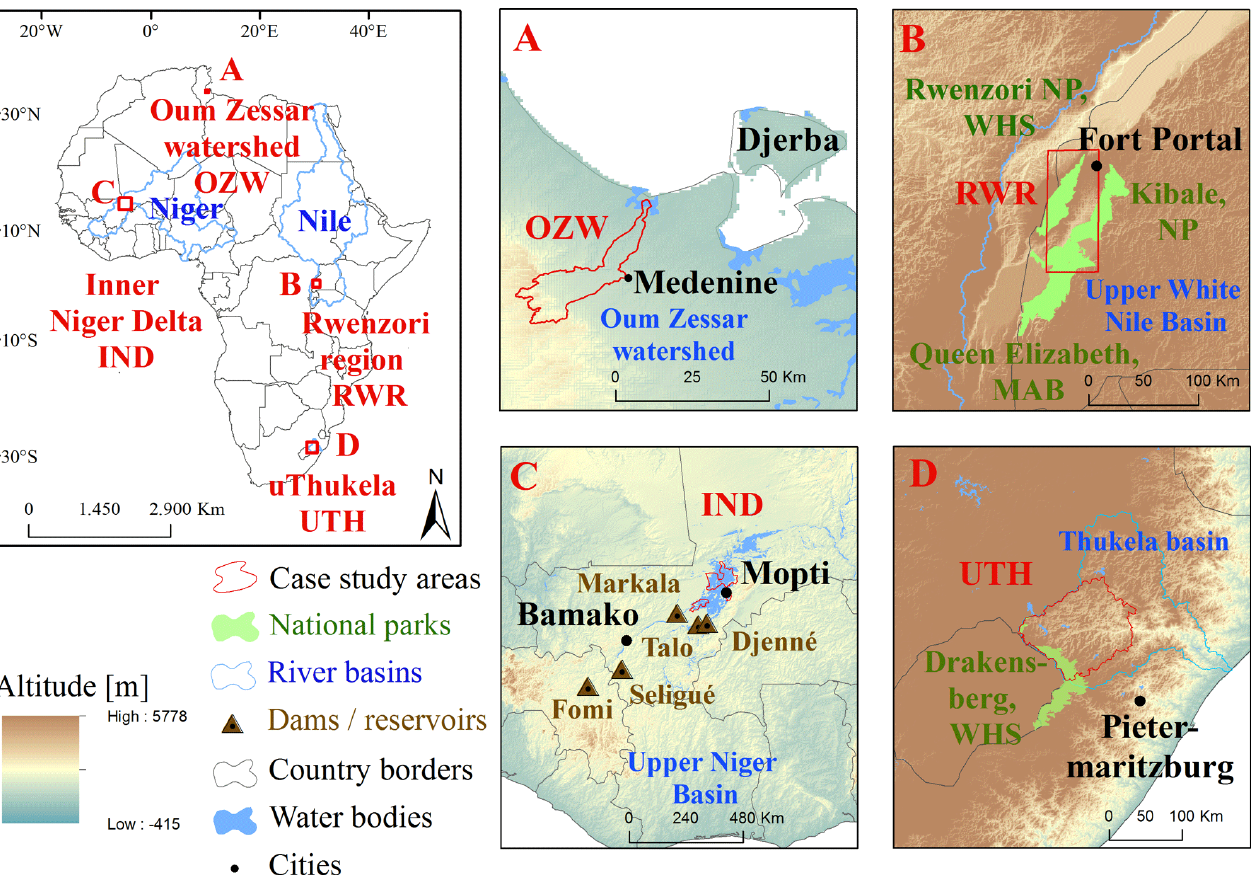
Fig. 1 . The four case study localities in Africa, (A) Oum Zessar watershed (Tunisia), (B) Rwenzori region (Uganda), (C) Inner Niger Delta (Mali), (D) upper Thukela/uThukela (South Africa). WHS: World heritage site, MAB: Man and the biosphere program, NP: National Park. Elevation map: SRTM 30 arc (USGS/EROS Data center, FAO GeoNetwork, http://www.fao.org/geonetwork/srv/en/